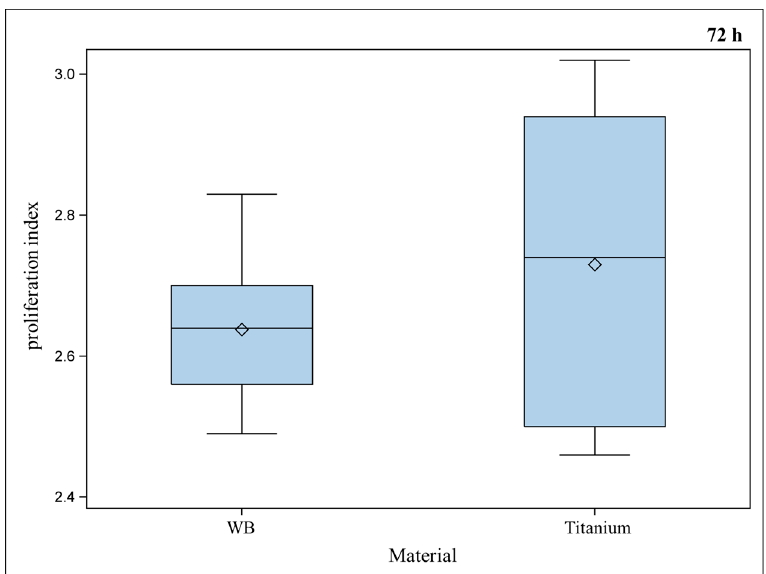
Figure 6. Proliferation index of murine osteoblasts settled on well bottom (WB) compared to porous titanium implants did not show a significant difference between the materials (Global F -test from the analyses of variance and pairwise multiple means comparisons with the Least Significant Difference test, * = p ≤ 0.05, n = 9; rhombus = mean; centered line = median).